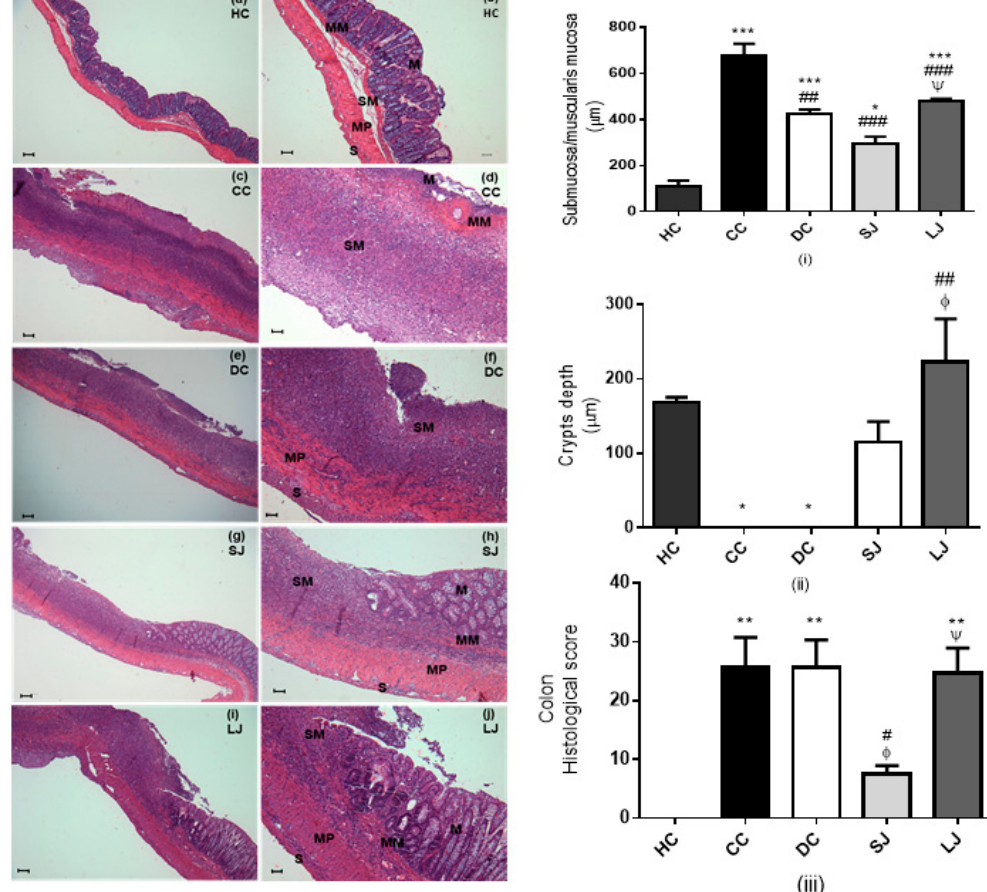
Figure 6. Histopathological assessment. Light micrographs of hematoxylin-eosin (HE)-stained colon from HC = healthy control ( a , b ); CC = colitis control ( c , d ); DC = drug (mesalazine) control ( e , f ); SJ = short-term EJP extract treatment ( g , h ); and LJ = long-term EJP extract treatment ( i , j ). Scale bars = 100 µm (a, c, e, g, i); 50 µm (b, d, f, h, j); ( i ) submucosa/ muscularis mucosa thickness (µm); ( ii ) crypt depth (µm); ( iii ) Histological score. Aqueous extract of Jaboticaba peel (EJP). Results are expressed as the mean ± error standard ( n = 6–8). * Indicates significant difference from HC group, # from CC group, Φ from DC, and Ψ from SJ by ANOVA and Tukey’s test (1 code = p < 0.05; 2 codes = p < 0.01; and 3 codes = p < 0.001). Mucosa (M), muscularis mucosae (MM), submucosa (SM), muscularis propria (MP), and serosa